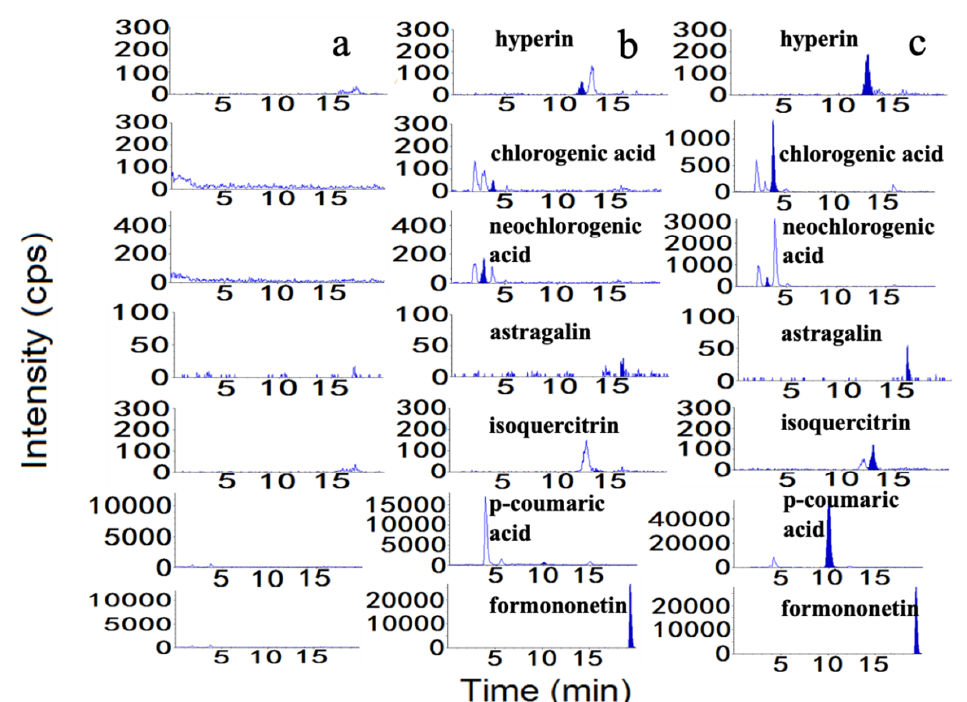
Figure 2. Representative chromatogram of ( a ) blank plasma, ( b ) blank plasma spiked with standard compounds at LLOQs, and ( c ) plasma sample.